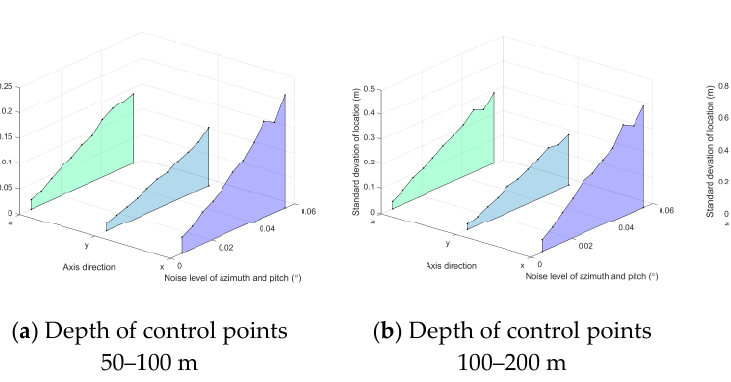
Figure 14. SDAAE vs. angle noise σ angle .